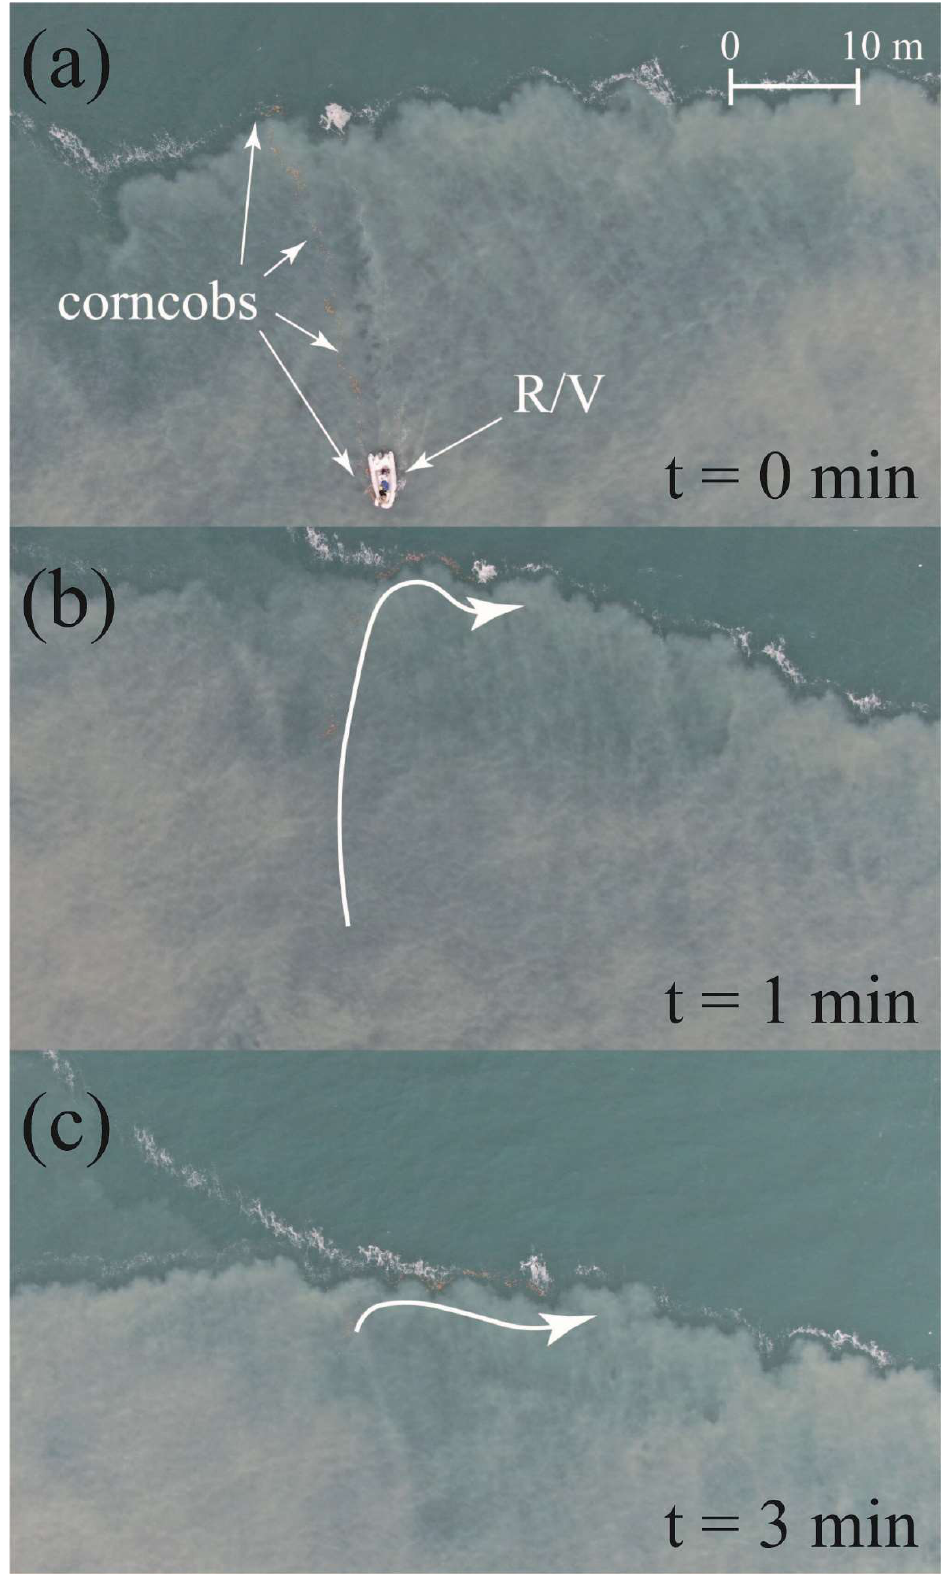
Figure 9. Aerial image of the far-field part of the Bzyb plume border illustrating motion of corncobs on 30 April 2022 at ( a ) the beginning of the “cross-border” experiment, ( b ) after 1 min, and ( c ) after 3 min. White arrows in panels ( b , c ) indicate motion of corncobs.